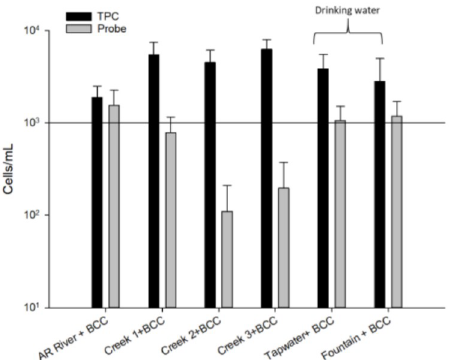
Figure 5. Bacterial abundance assessed in several different surface water samples; spiked with B. cenocepacia HI2976 (10 CFU/mL) using the TPC and Kef probe